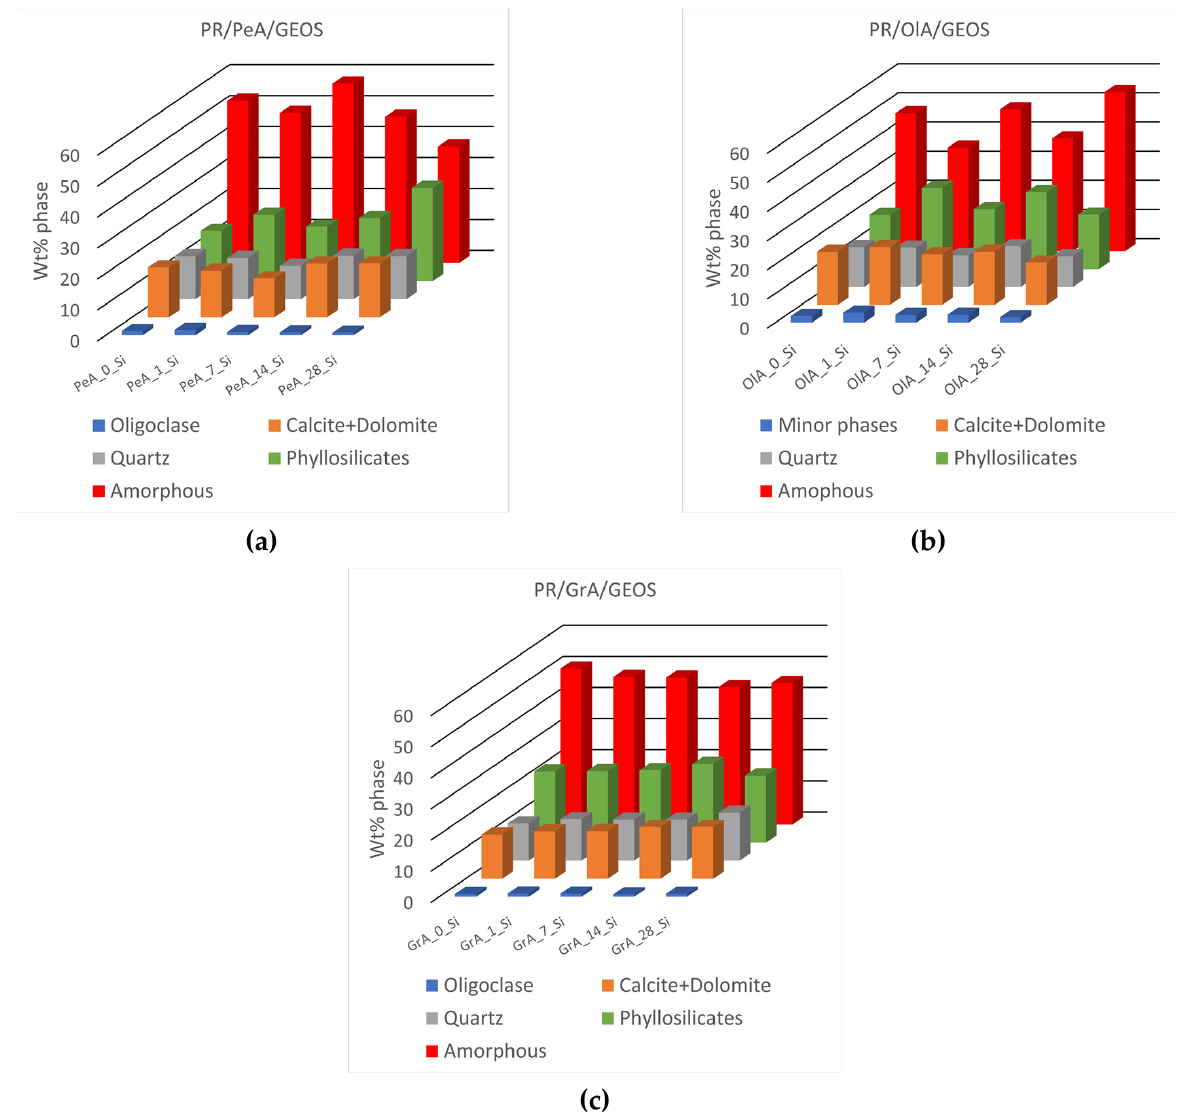
Figure 6. Histograms reporting quantitative analyses by Rietveld refinement of XRPD for PR/PeA/GEOS ( a ), PR/OlA/GEOS ( b ), and PR/GrA/GEOS ( c ) samples. Quantitative results are given in wt %. The amorphous content was recalculated based on Si as an external standard. The results of QPA are reported in Figure 6. The abundance of the crystalline and amorphous phase wt% was calculated using the Rietveld method for the PR/PeA/GEOS, PR/OlA/GEOS, and PR/GrA/GEOS samples cured for 0 to 28 days. Fe-SEM photos of raw clayey soil mixed with biomass ash samples at different magni- fications are shown in Figure 7. Images of raw soil show clay minerals with typical lamellar structures stacked on top of each other and semi-spherical agglomerates of added biomass fly ashes. Figure 8 shows the mixtures after 28 days of